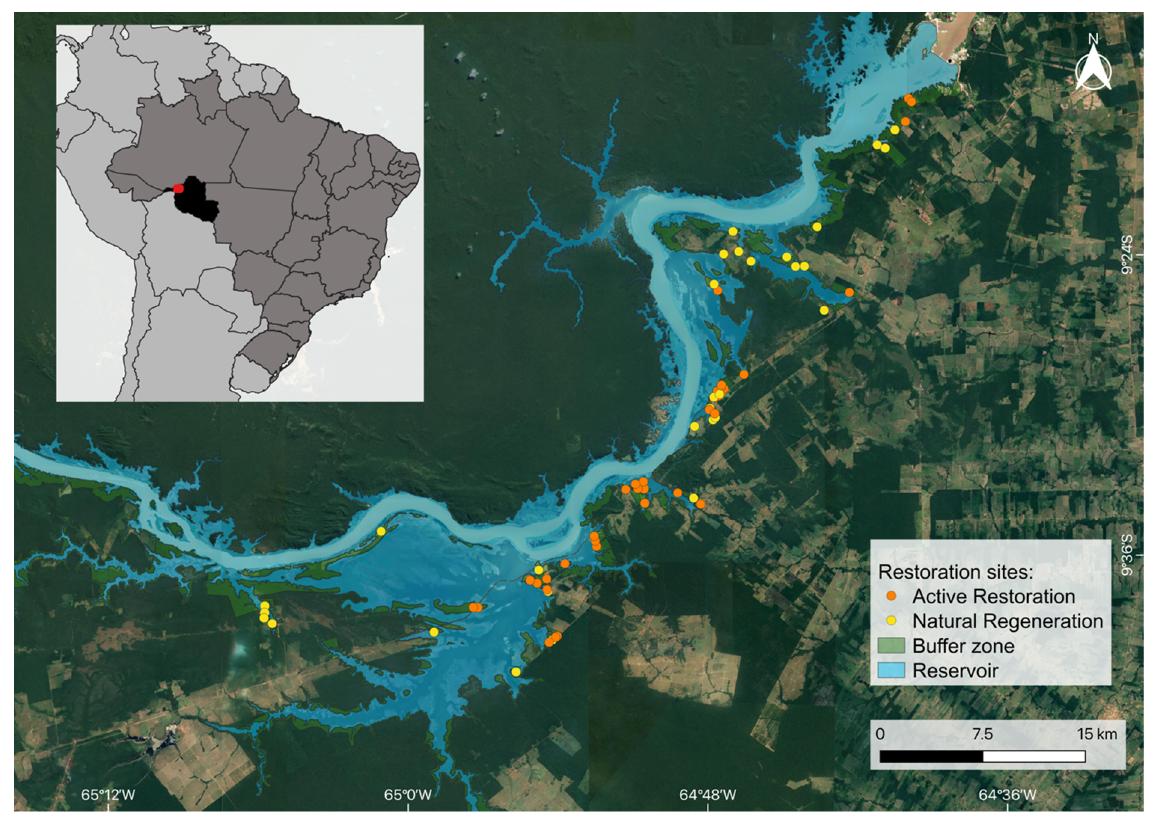
Figure 1. Active restoration and natural regeneration sites sampled in the buffer zone of the Jirau Hydroelectric Reservoir along the upper Madeira River, Rondônia State (Brazil).